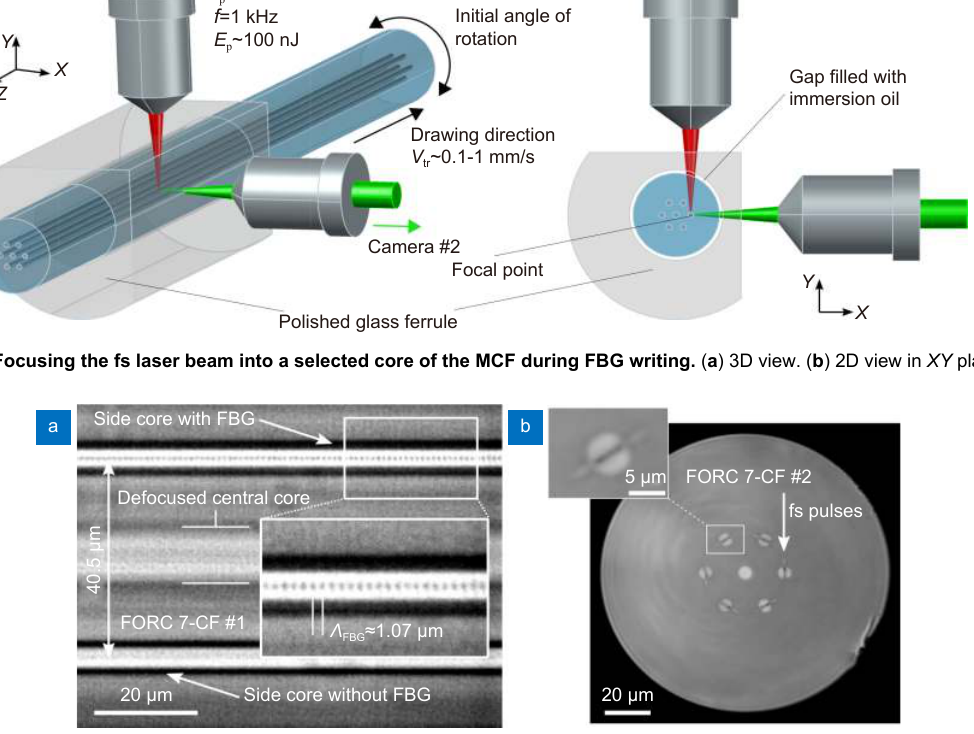
Fig. 6 | Microphotographs of point-by-point FBGs written individually in the MCF cores. ( a ) Single FBG in one of the side cores of FORC 7- CF #1. ( b ) 6 FBGs in the side cores of FORC 7-CF